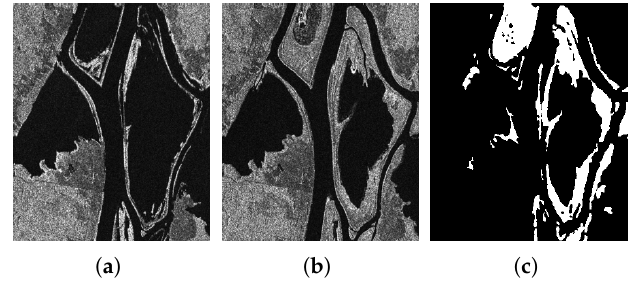
Figure 9. Ottawa dataset. ( a ) X 1 ; ( b ) X 2 ; ( c ) ground